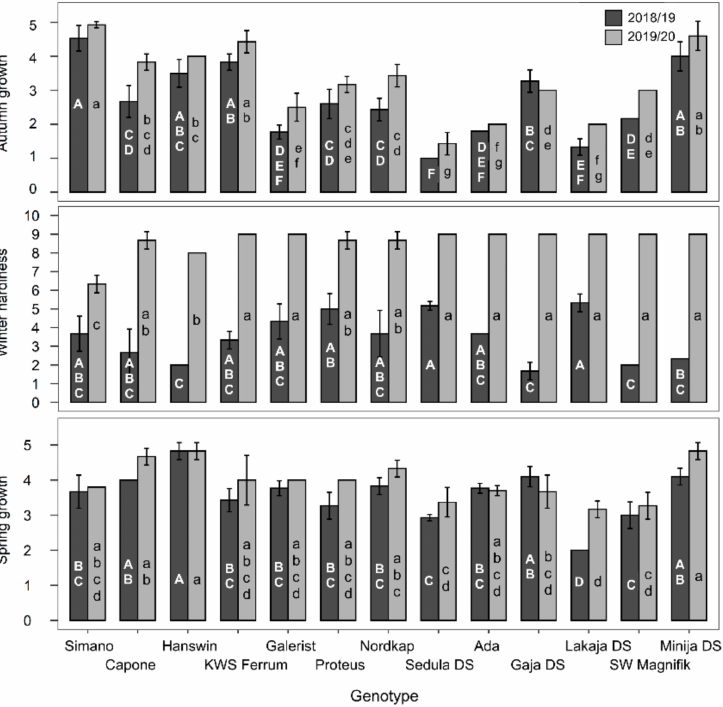
Figure 2. Autumn growth, winter hardiness and spring growth of 13 winter wheat varieties scored following the two years of field experiments. Means ± SD, n = 3. Within either season of 2018/2019 (upper case) or 2019/2020 (lower case), cultivars denoted with the same letter are not significantly different (Tukey’s honestly significant difference test, p >